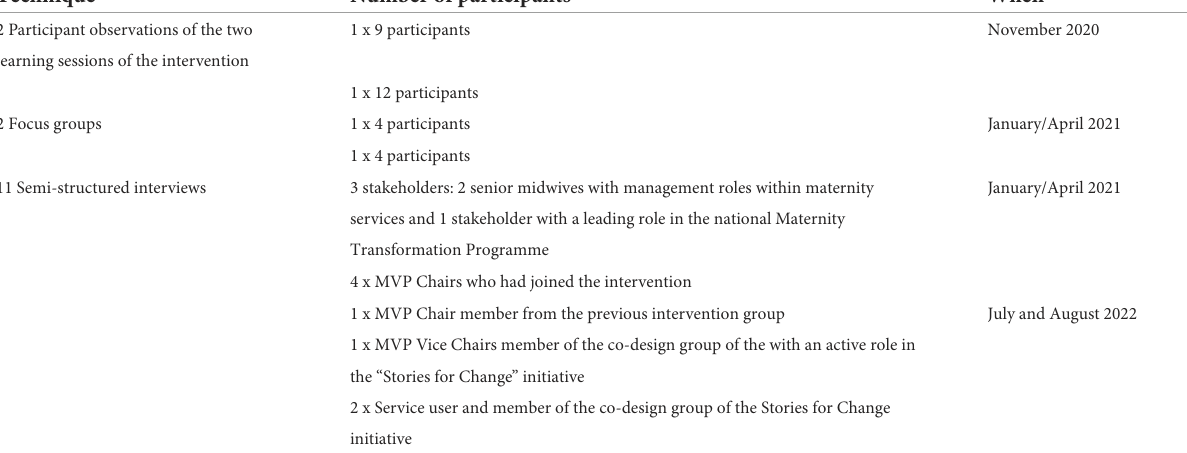
TABLE 2 Summary of qualitative data collected. Technique Number of participants